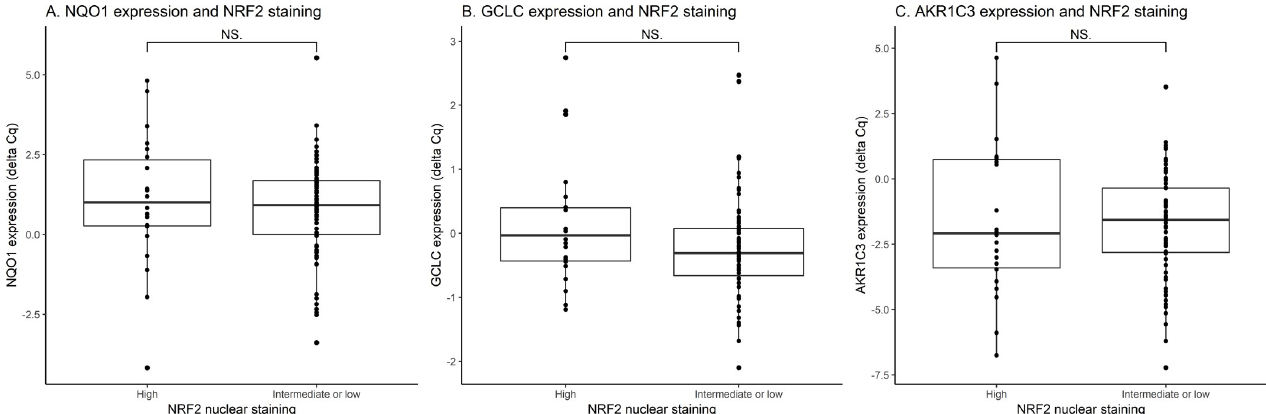
Fig 2. NRF2 target genes expression and NRF2 immunostaining in endometrial tumors. NQO1 , GCLC and AKRC3 expressions measured by quantitative RT-PCR are shown as interquartile boxplots in tumors with high or with intermediate/low NRF2 nuclear staining. NS: non-significant. p -values computed using Wilcoxon